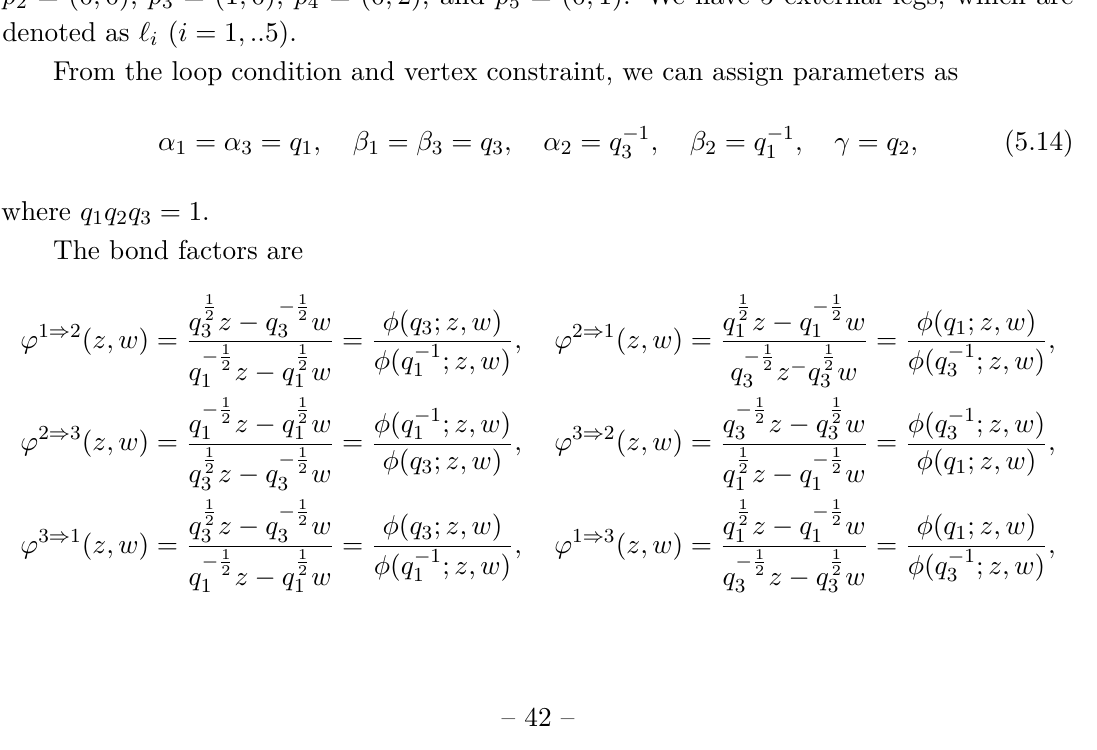
= (1 , 1) , p = (0 , 0) , p = (1 , 0) , p = (0 , 2) , 1 2 3 4 1 , .., ‘ 5